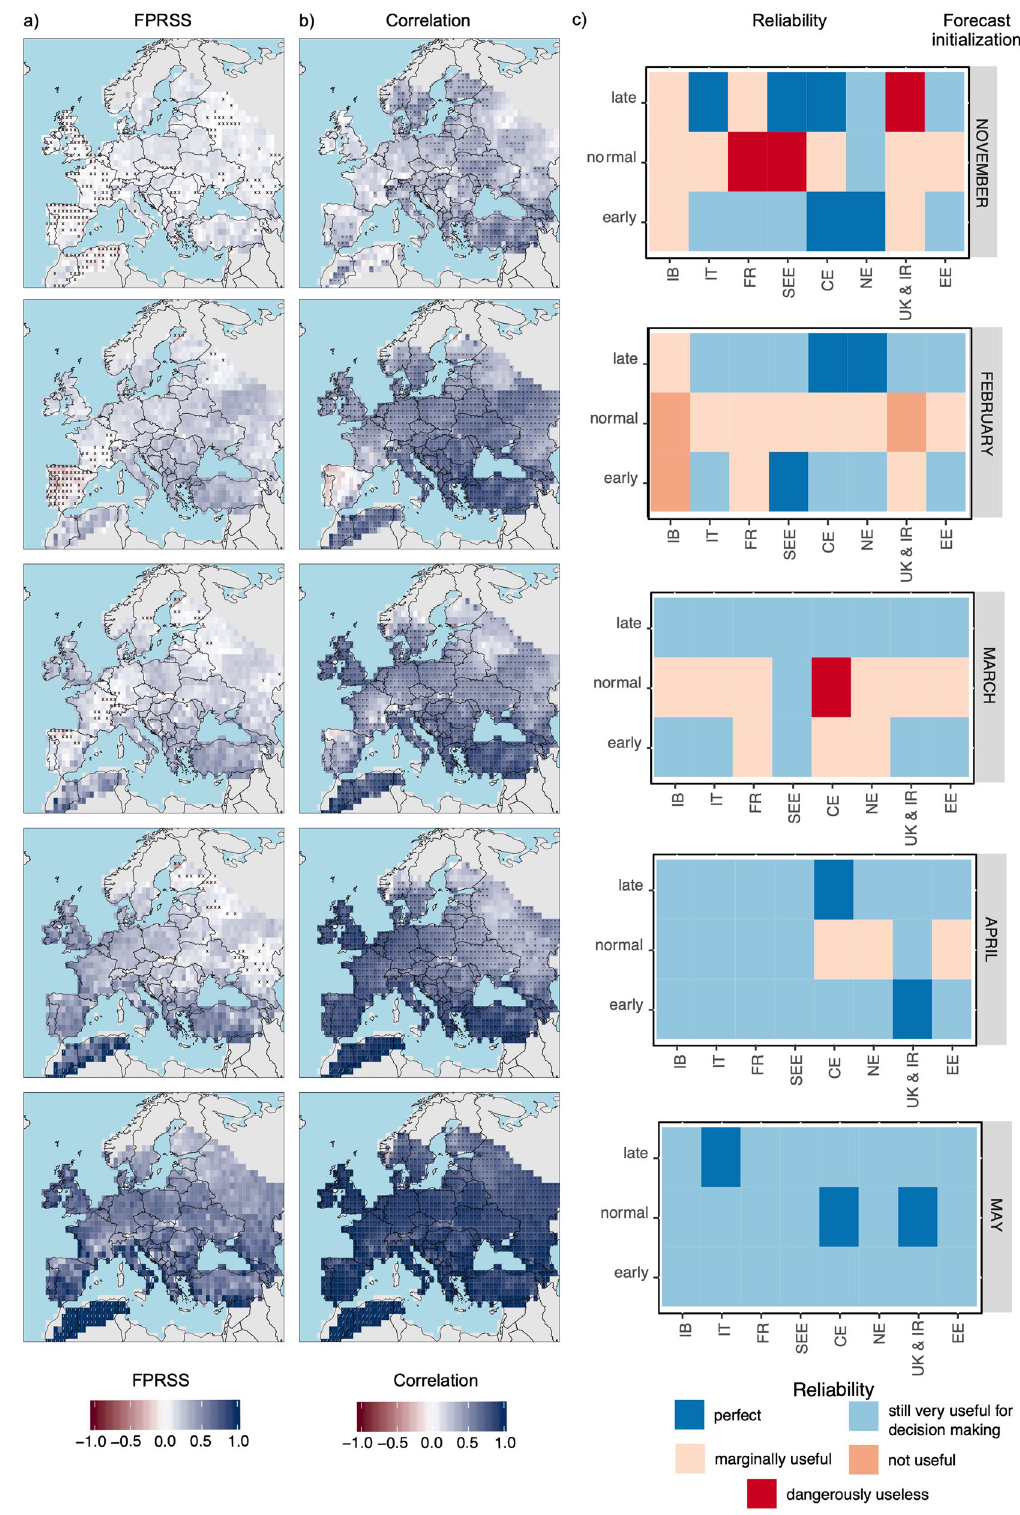
Fig. 1 Skill and reliability of wheat- fl owering prediction. a Fair ranked probability score for predicted wheat- fl owering dates categorized in terciles (early/normal/late occurrence). The skill maps are shown for the seasonal predictions initialized in November, February, March, April, and May. Cross marks denote regions without prediction skill. b Correlation between observed fl owering dates and the ensemble median of the seasonal predictions. Regions with signi fi cant correlation are denoted with “ + ” . c Reliability for the probabilistic categorical forecasts of fl owering occurrence (early/normal/late) in different regions of Europe. Similar to a and b , the reliability is presented for different forecast